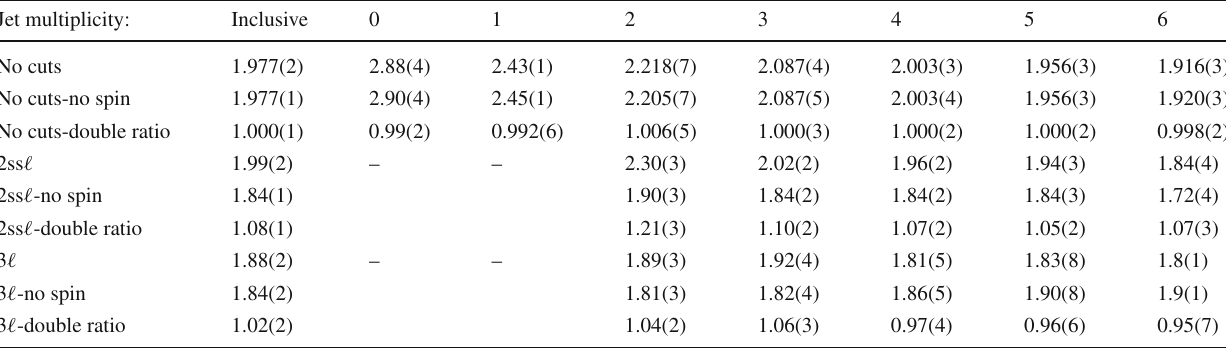
Fig. 3 Spin correlation effects on lepton pseudo-rapidities and jet multiplicities. The muons in the upper plots are the leading in p T regardless their origin Table 1 Charge ratio σ t ¯ tW + /σ t ¯ tW − and double ratios (spin over no spin) in different signatures. The scale uncertainties can be taken to be correlated and are therefore of the order of the statistical error (in parantheses) and are not